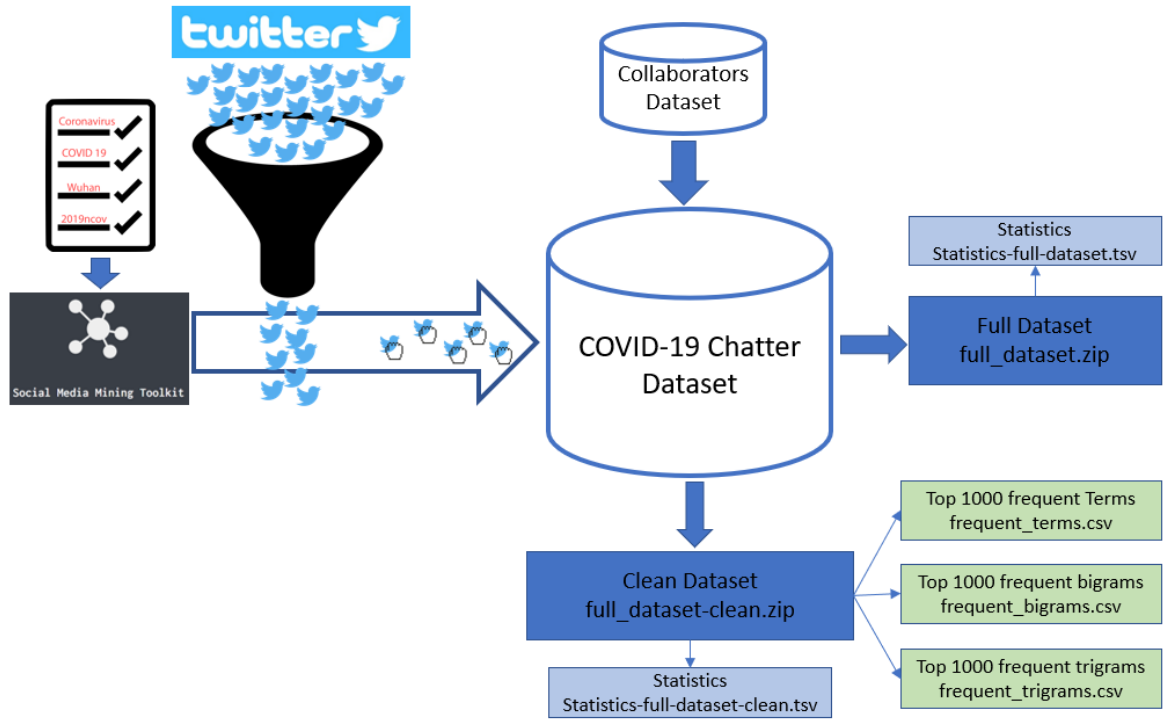
Figure 1. Dataset gathering and construction steps.